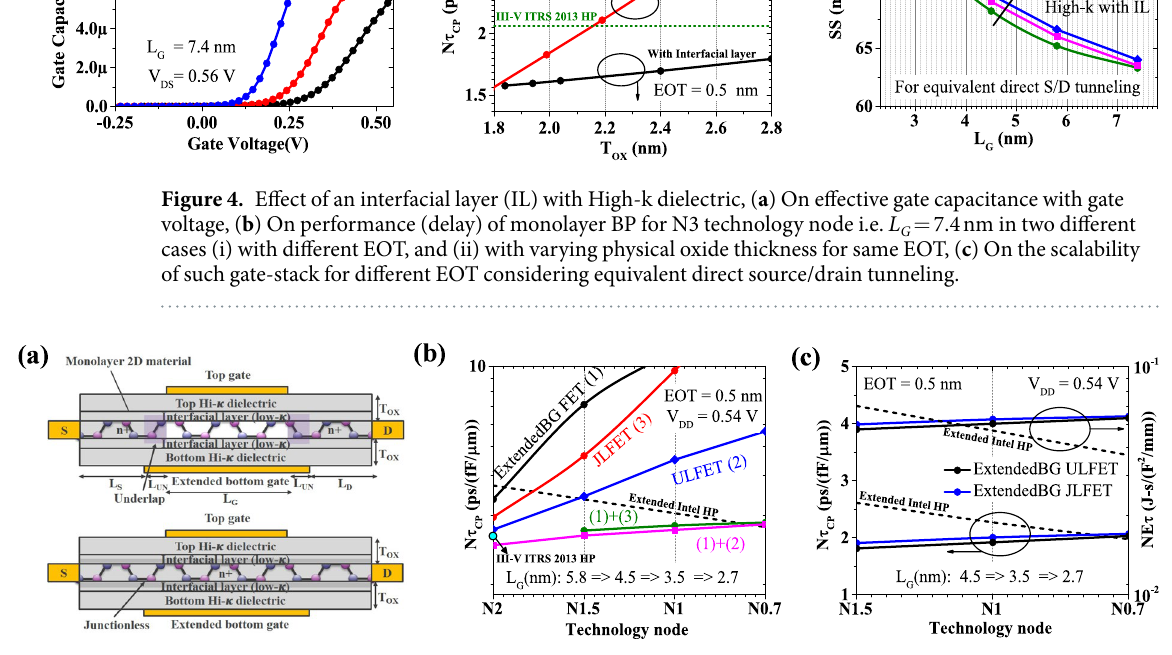
Figure 5. Reducing direct S/D tunneling for N2 and beyond ( a ) Device structures showing extended back-gate (BG) with underlap (ULFET) and extended BG with junctionless doping profile. (JLFET) ( b ) Effect of different combination of device structures on performance of monolayer BP FET for N2 and beyond for fixed EOT and supply voltage, showing the need of extended back-gate with UL/JLFET for L G = 4.5 nm and beyond, ( c ) Delay and energy-delay product for extended BG UL/JFET ( L UN = 2,3,4 nm for N1.5, N1, and N0.7 respectively) showing that although we meet the performance requirement for N1 and N0.7, the energy-delay product doesn’t scale.